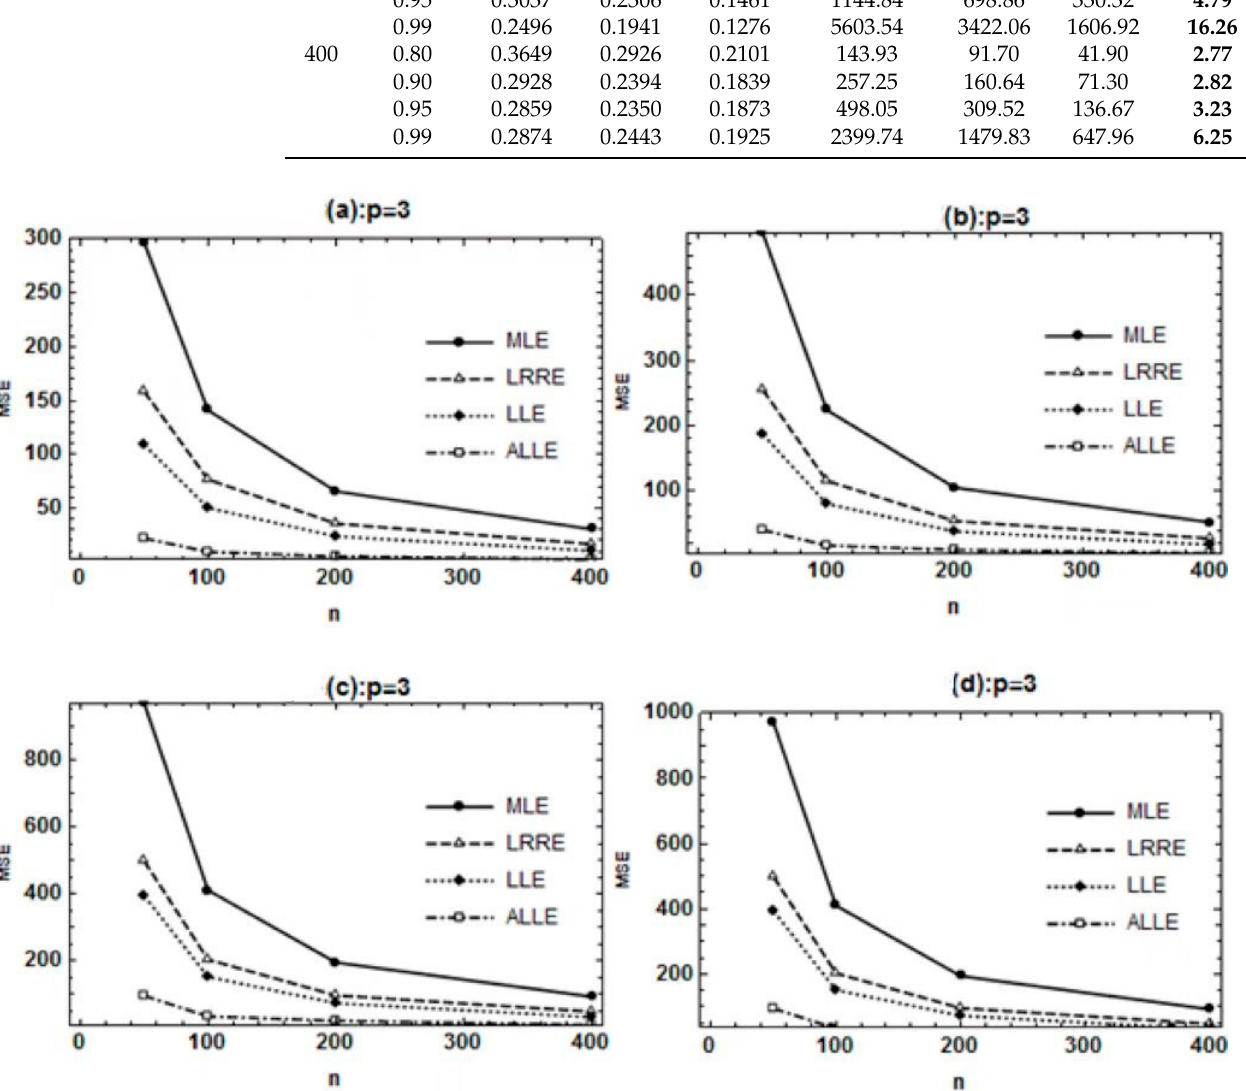
Figure 2. The BLRM estimators for various n : ( a ). ρ = 0.80, ( b ). ρ = 0.90, ( c ). ρ = 0.95, ( d ). ρ = 0.99 . Table 1. Bias and MSE values of the estimators for p = 3.